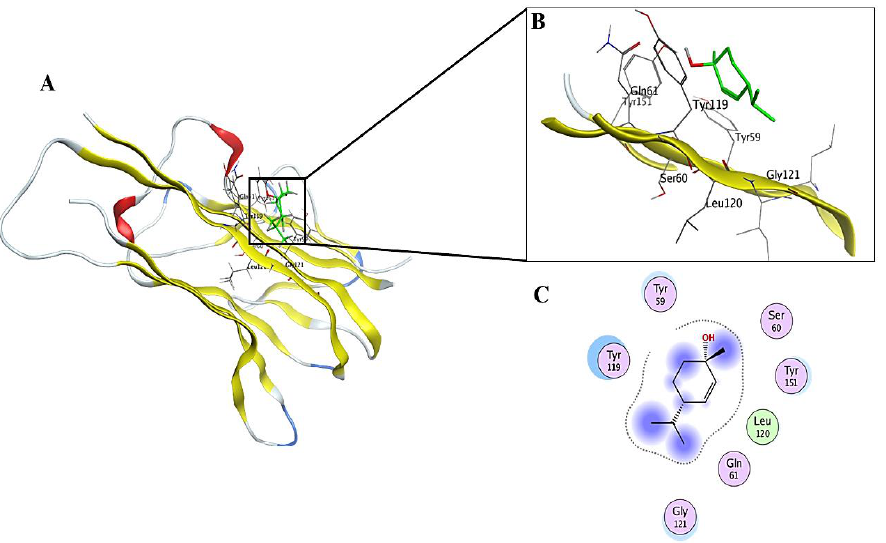
Figure 5. 2D and 3D interactions complex of compound 14 (bornyl acetate) with the COX-2 receptor. ( A ) receptor ligand complex, ( B ) 3D interactions of ligand with the active site, ( C ) 2D interactions of ligand with the active site.